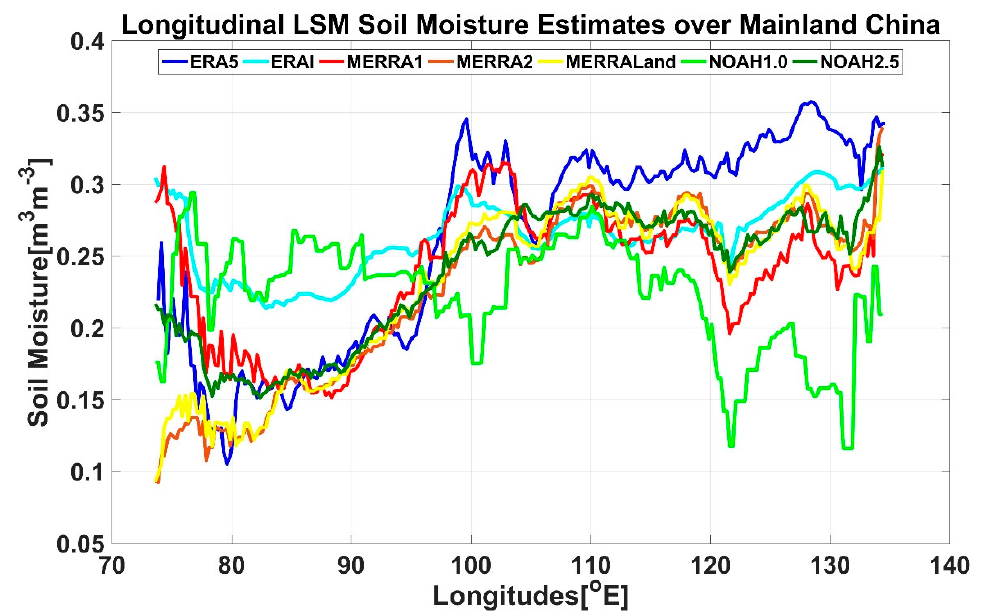
Figure 7. The longitudinal variability (west-east pattern) of soil moisture estimates from the LSMs.